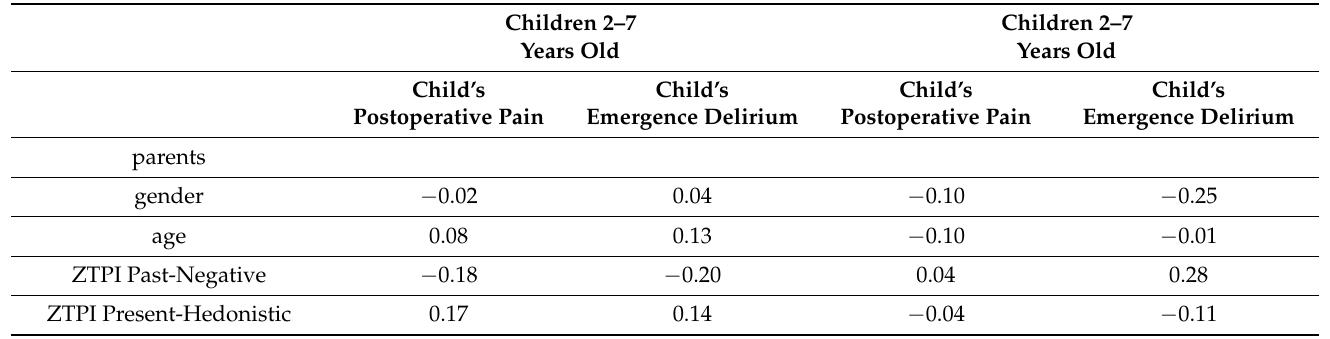
Table 2. Correlations between the parent’s time perspective, child’s postsurgical pain, and child’s emergence